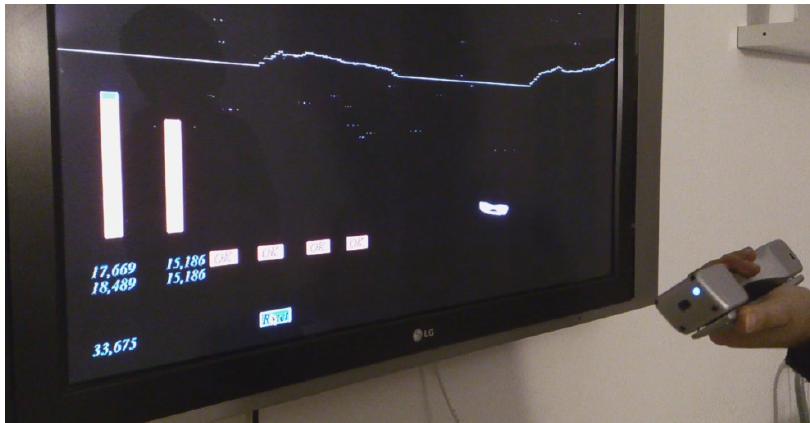
Figure 8. Virtual object on the screen.